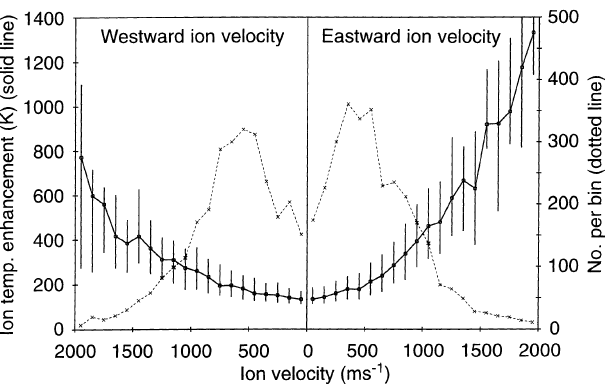
Fig. 5. Field-parallel ion temperature enhancement as a function of ion velocity during identified intervals of ion frictional heating, sub- divided according to the orientation of the field-orthogonal zonal component of the ion velocity. The solid line shows the median enhancement in each 100 m s ) 1 width velocity bin, with vertical lines which indicate the range bounded by the upper and lower quartiles. The dotted line represents the number of estimates of parallel temperature enhancement in each